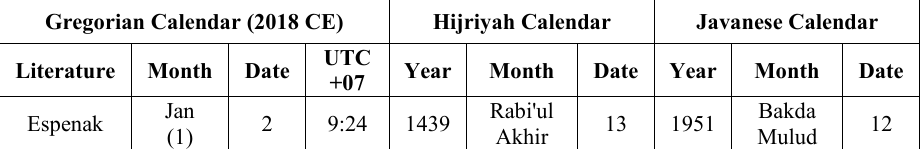
Table 4. Date Conversion from Gregorian Calendar to Hijriyah Calendar and Javanese Calendar